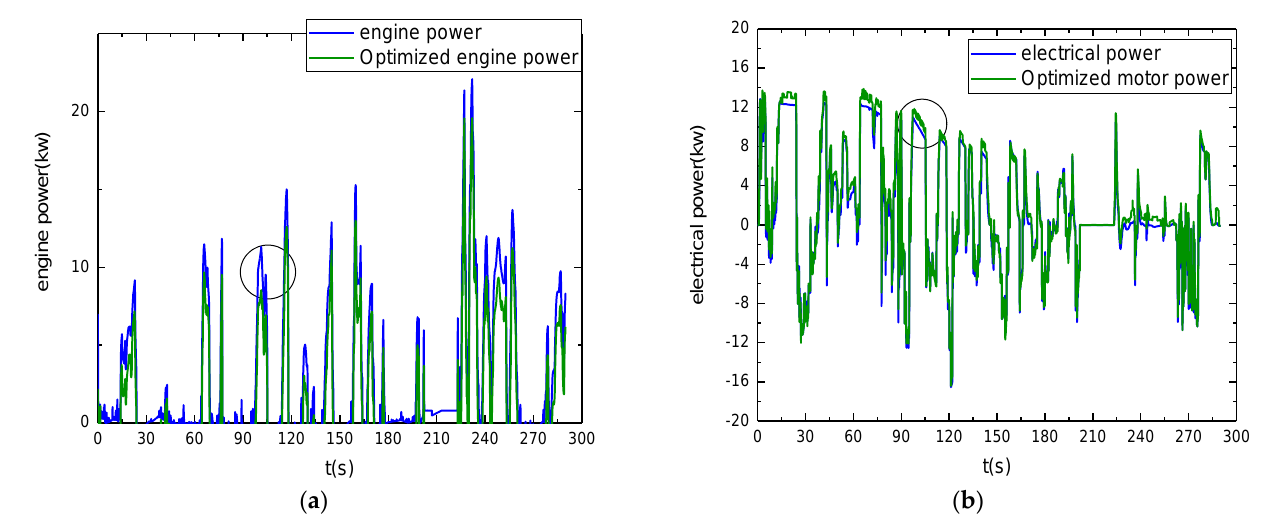
Figure 16. Power variation comparison: ( a ) Comparison of engine output power; ( b ) Motor output power comparison.